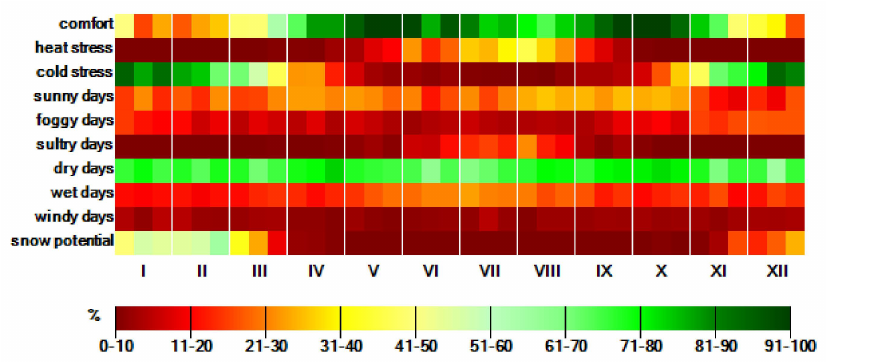
Figure 11. CTIS for Słosz ó w in